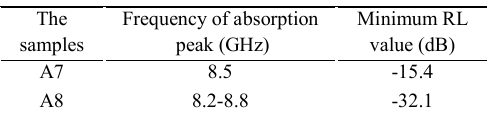
Table 4. Microwave absorption properties of the samples with two absorb